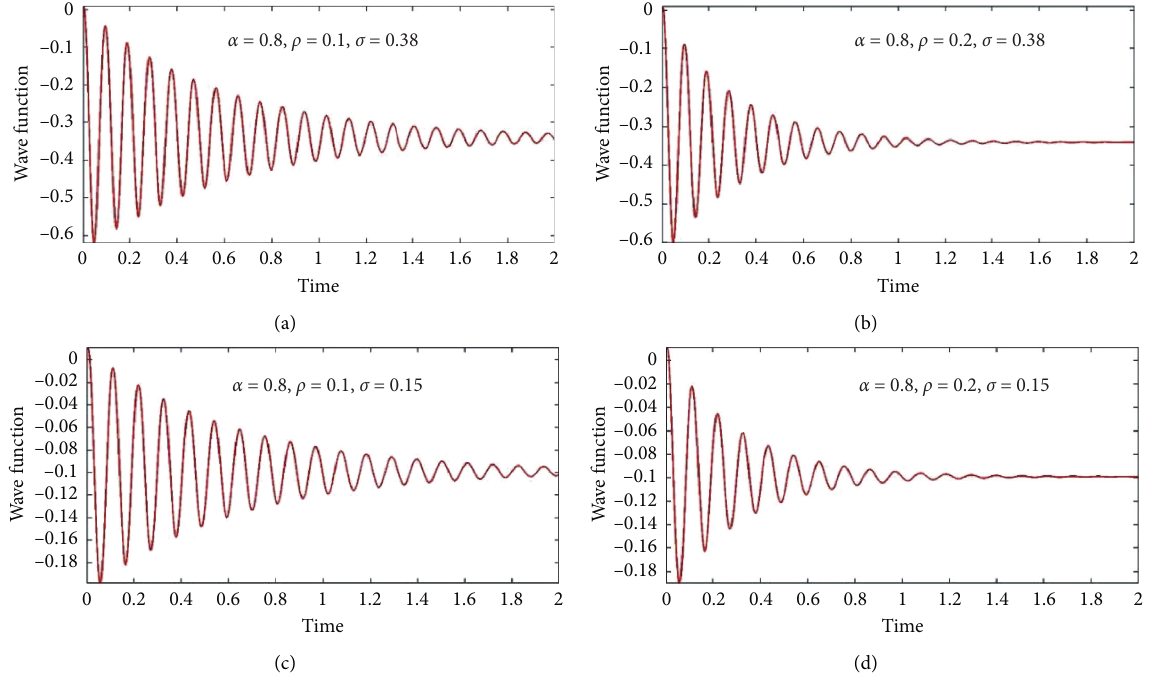
Figure 4: Wavefunctiongeneratedfromthepartialdifferentialequationathighkineticenergy.(a) α � 0 . 8 , ρ � 0 . 1 , σ � 0 . 38;(b) α � 0 . 8 , ρ � 0 . 2 , σ � 0 . 38; (c) α � 0 . 8 , ρ � 0 . 1 , σ � 0 . 15; (d) α � 0 . 8 , ρ � 0 . 2 , σ � 0 .